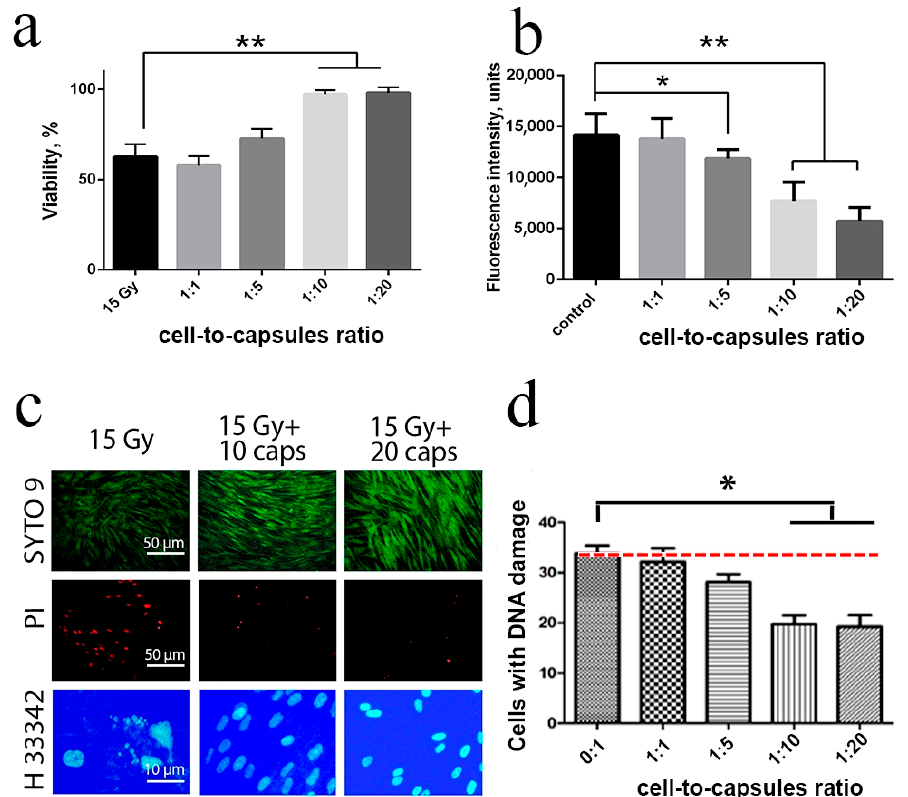
Figure 7. Viability (via MTT assay) of human mesenchymal stem cells pre-treated with nanoceria-loaded polyelectrolyte microcapsules 48 h after exposure to X-rays at a dose of 15 Gy ( a ). Reactive oxygen species (ROS) level determination by staining with dichlorofluorescein ( b ). Live / Dead assay and micronuclei analysis after X-ray irradiation of cells initially treated with nanoceria-loaded polyelectrolyte microcapsules 48 h after exposure ( c ). Quantitative analysis of micronuclei in hMSC treated with nanoceria-loaded microcapsules after X-ray irradiation (15 Gy) ( d ). *—Significant differences as estimated by t -test with Welch’s correction, * p < 0.05, ** p < 0.0001, Control—X-ray irradiation (15 Gy) of the cells without nanoceria-loaded polyelectrolyte microcapsules. Cells were treated with nanoceria-loaded polyelectrolyte microcapsules 24 h before irradiation.